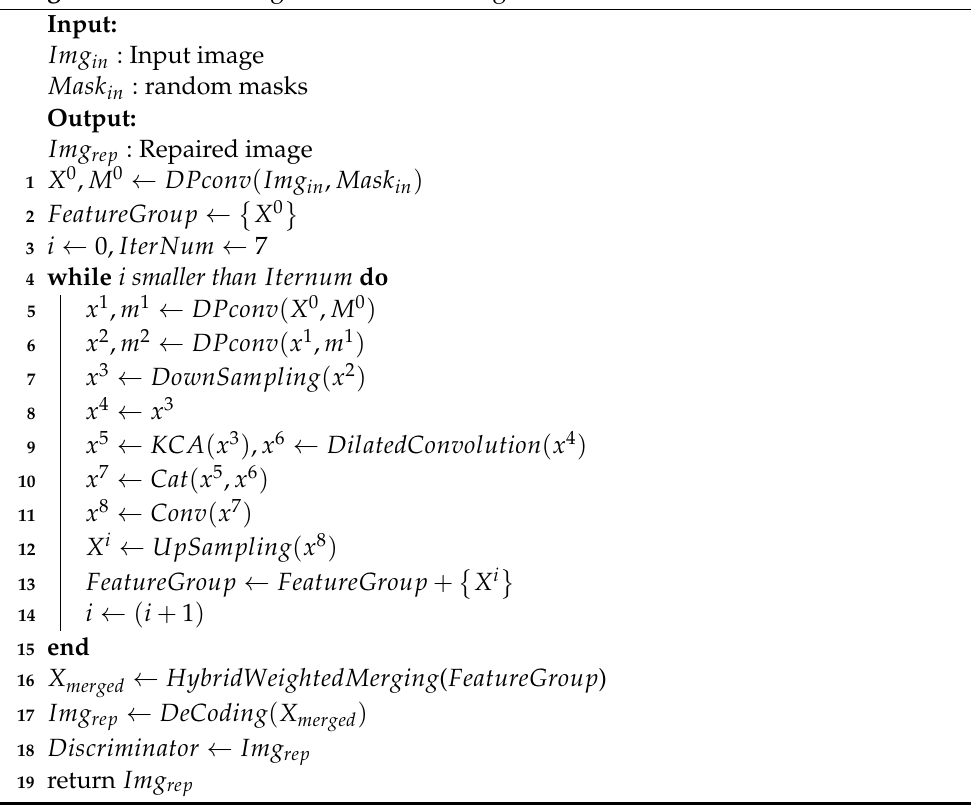
Algorithm 1: Multi-stage Feature Reasoning